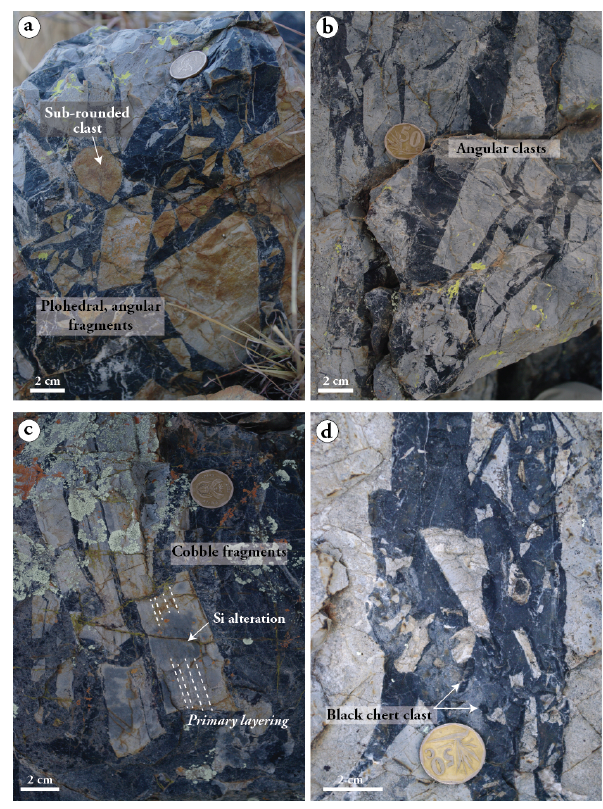
Figure 8. Selection of dikes showing the most common shapes of country rock fragments. They range in size from <1 to 40–50cm (<10cm in average) and show a wide range of polyhedral shapes, from sub-rounded (a) to cobble-like (c) , the majority being highly irregular. More than 90% of embedded fragments are from the sur- rounding host rock; the remaining 10% consist essentially of clasts eroded from older veins, such as the translucent black chert clasts in (d) . The primary layering is generally well preserved in host rock fragments although zones of silicification can be found (c)